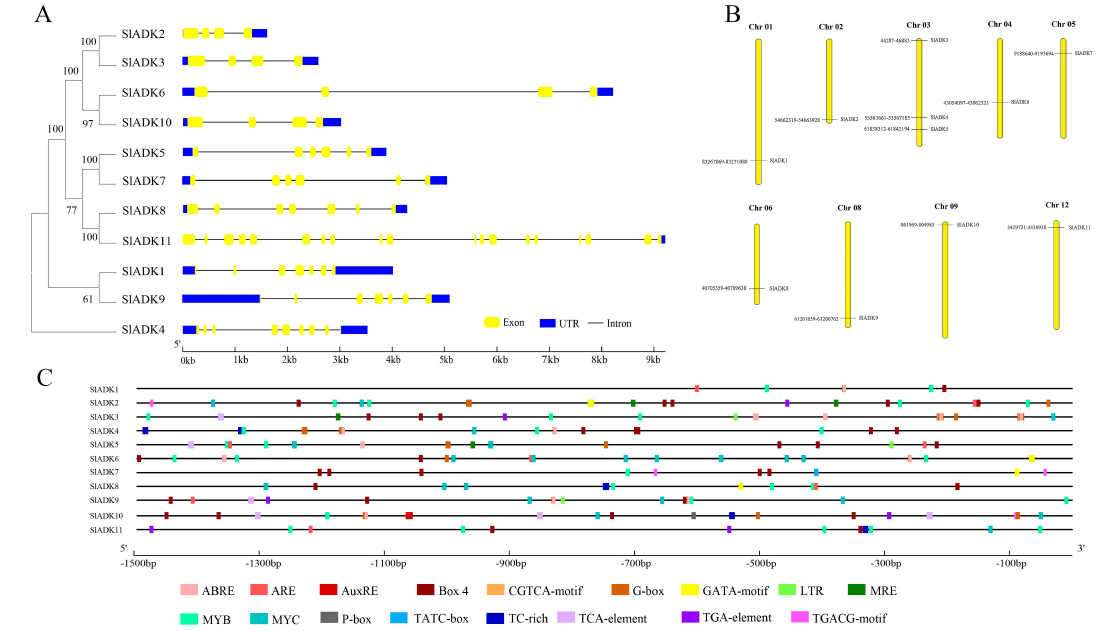
Figure 3. Phylogenetic relationships, gene structures, chromosomal locations, and predicted cis-elements of the SlADK gene family. ( A ) Phylogenetic tree (left) of 11 SlADK proteins. The unrooted neighbor-joining phylogenetic tree was constructed with MEGA7 using full-length amino acid sequences of 11 SlADK proteins, and the bootstrap test replicate was set as 1000 times. Exon/intron organization (right) of SlADK genes. Yellow boxes represent exons, and black lines with same length represent introns. The UTR region of SlADK genes are indicated in blue boxes. The length of exons can be inferred by the scale at the bottom. ( B ) Chromosomal location of SlADK genes. The number of chromosomes is indicated at the top of each chromosome. Also, the numbers at the left and right of each chromosome represent genomic locations and names of SlADK genes, respectively. ( C ) Predicted stress- and hormone-related cis-elements in SlADK promoters. Promoter sequences ( − 1500 bp) of 11 SlADK genes were analyzed by PlantCARE. The upstream length to the translation start site can be inferred according to the scale at the bottom.